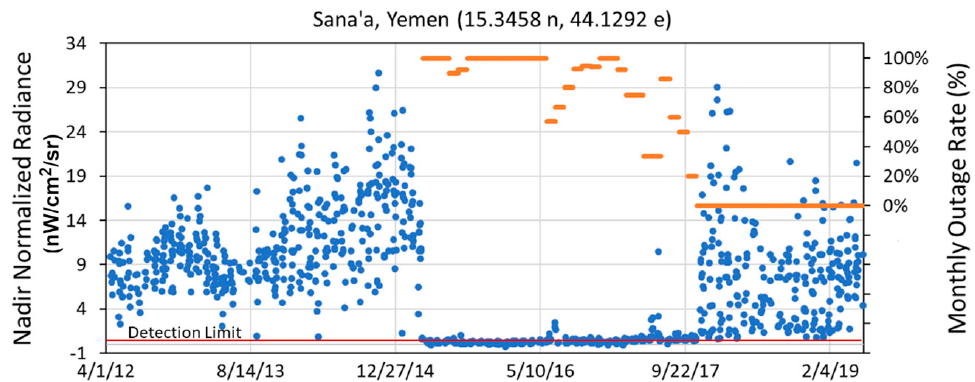
Figure 14. Monthly outage rates (orange horizontal lines) following the aerial bombing of Sana’a,